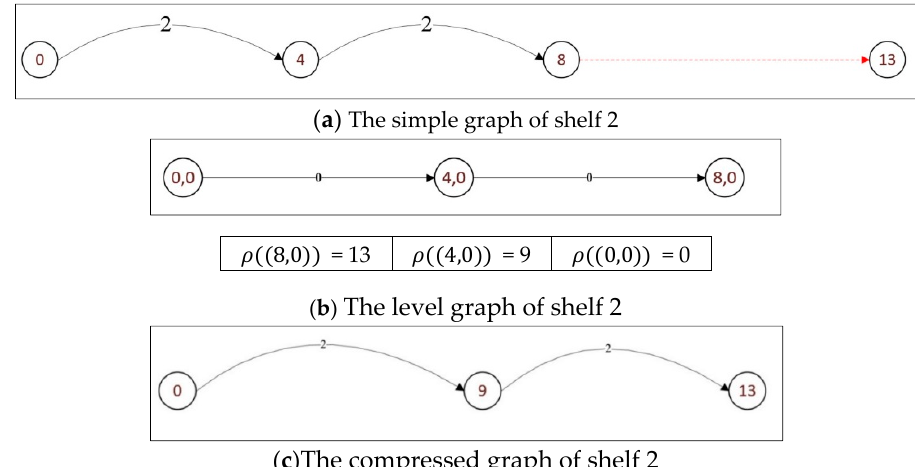
Figure 7. The three graphs of shelf 1.